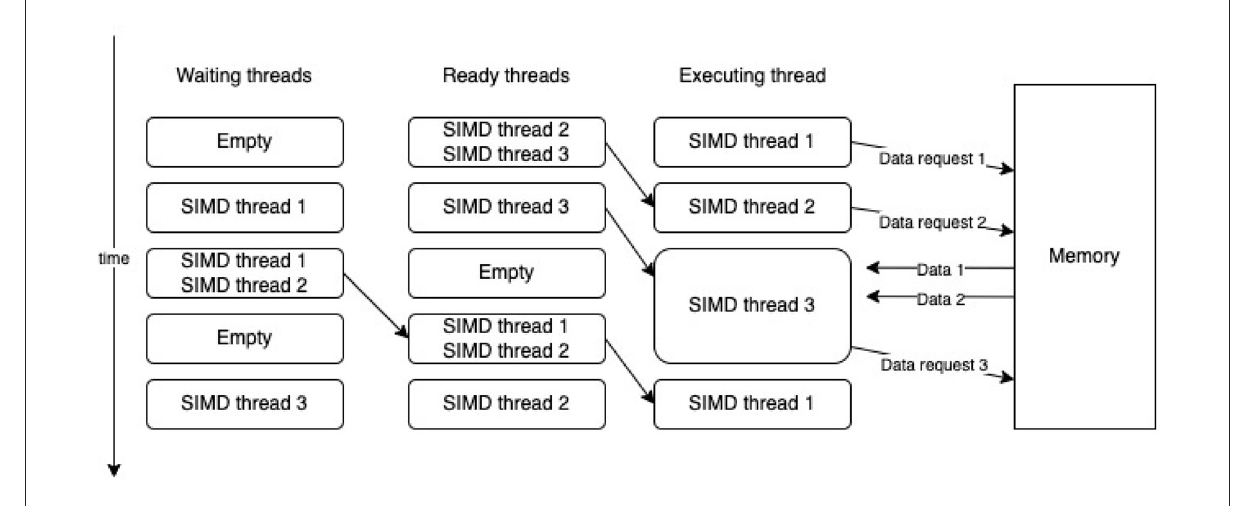
FIGURE3 Switching between SIMD